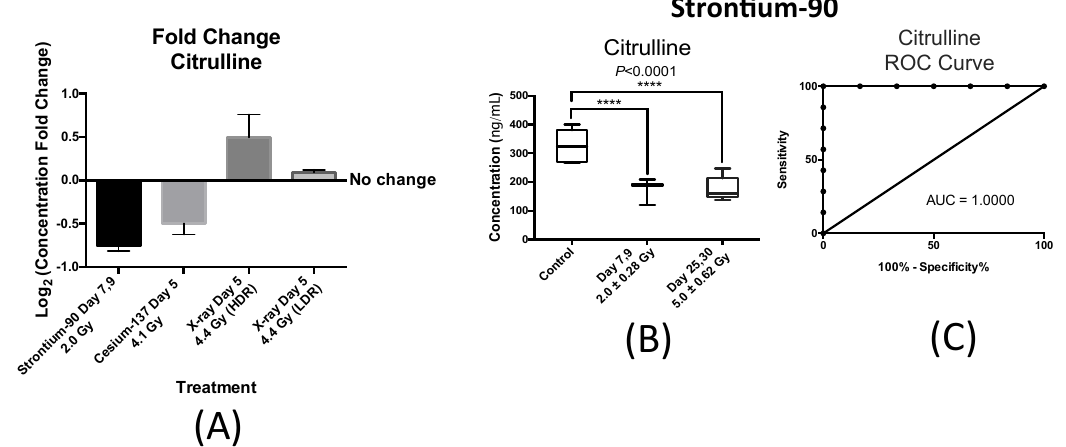
Figure 4. ( A ) changes in the urinary concentration of citrulline from mice after various exposure types. The y -axis represents log 2 fold change after exposure and x -axis represents each of the three exposure senarios; 90 Sr exposure at days 7–9 after exposure at cumulative dose of 2.0 Gy, 137 Cs at day 5 after exposure at cumulative dose of 4.1 Gy, and X-ray rays at day 5 post 4.4 Gy exposure at high dose rate (HDR) of 1.1 Gy/min and low dose rate (LDR) of 0.00309 Gy/min. 90 Sr and to a lesser extent 137 Cs exposure induced a decrease in the urinary levels of citrulline, while X-ray exposure (HDR) had an opposite effect. No statistically significant change in the urinary concentration of calcitroic acid was detected after LDR exposure; ( B ) box plot representation of urinary concentration of citrulline after 90 Sr-exposure. The calculated mean ± standard error of the mean (SEM) for the control mice was 326.3 ± 24.6 ng/mL, for days 7–9 at cumulative skeleton dose of 2.0 Gy was 182.8 ± 10.7 ng/mL, and for days 25–30 at 5.0 Gy was 176.1 ± 18.8 ng/mL. Each study group contained at least six samples. Concentration fold change was calculated by the log 2 ratio of urinary concentration of citrulline in mice exposed to 90 Sr to that of citrulline in control mice at each time-point; ( C ) ROC analysis of citrulline at time-point days 7–9 after 90 Sr-exposure at cumulative average dose of 2.0 Gy compared to controls shows the robustness of the biomarker classification. The predictive power of the biomarker at cutoff of 268.7 ng/mL is at 83.3% specificity and 100% sensitivity. (****) denotes the statistical significance in terms of p -value ( p -value < 0.0001) of the change in concentration of citrulline after exposure to 90 Sr in mice at each of the two